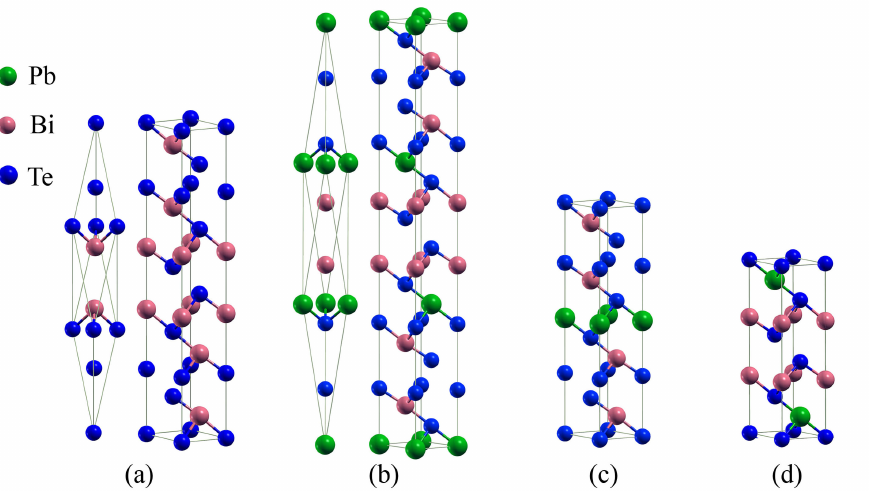
Figure 1. ( a ) Primitive and conventional cell of Bi 2 Te 3 , ( b ) primitive and conventional cell of PbBi 2 Te 4 , ( c ) conventional cell of PbBi 4 Te 7 , ( d ) conventional cell of Pb 2 Bi 2 Te 5